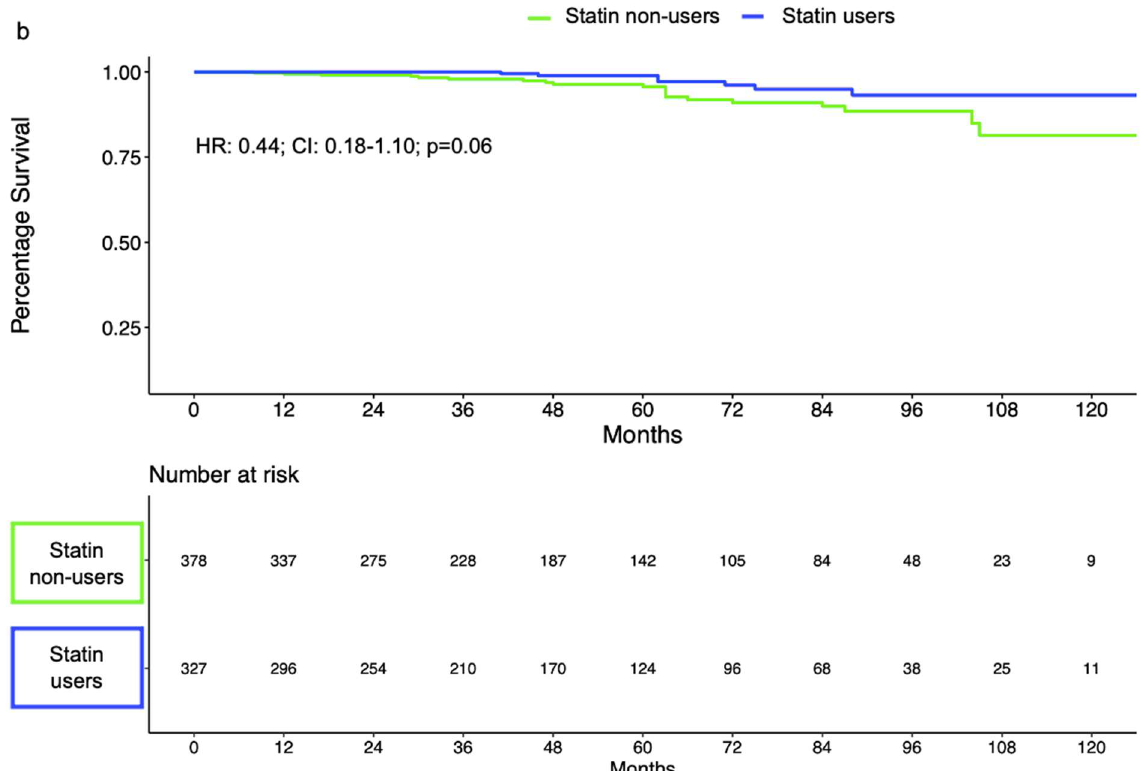
Figure 3. BCR-free survival in D’Amico low-risk ( a ) and intermediate-risk ( b ) patients treated with LDR. Table 4. Univariable and multivariable Cox regression models predicting biochemical recurrence among LDR-treated patients (low and intermediate), according to statin use.